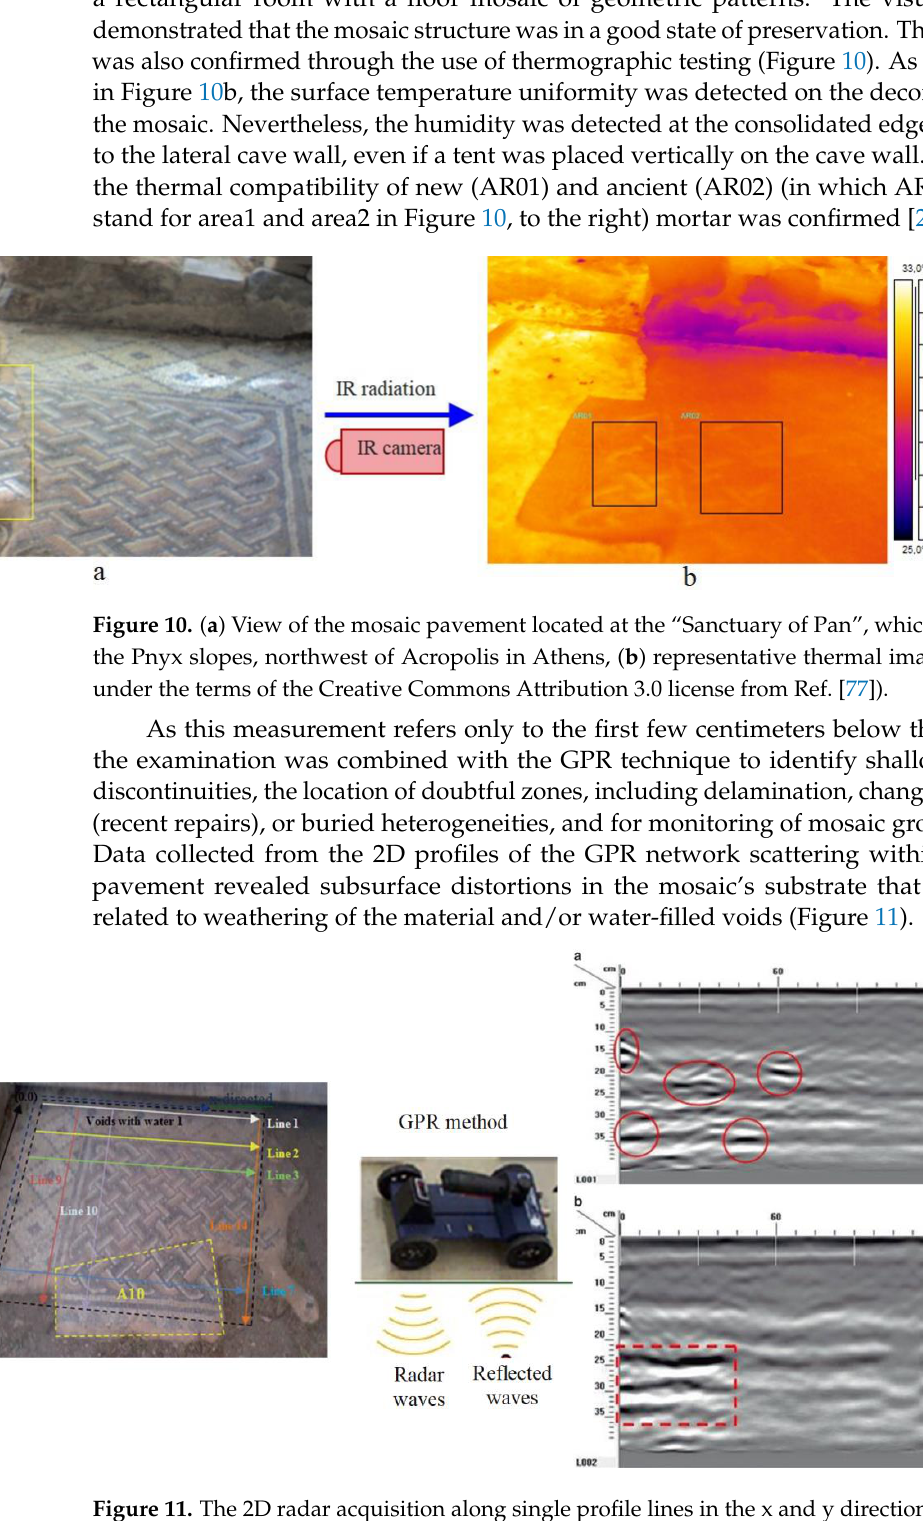
Figure 9. ( a ) The 2D radar data acquisition along single profile lines in the x- and y- directions of the mosaic floor, ( b ) The 2D radar profile acquired along the y- directed line 1, time zero, and migrated profile. (Reprinted with permission from Ref. [24]. Copyright: 2017 Ftikou, Ε .; Theodorakeas, P.; Cheilakou, Ε . ; Koui, Μ .).